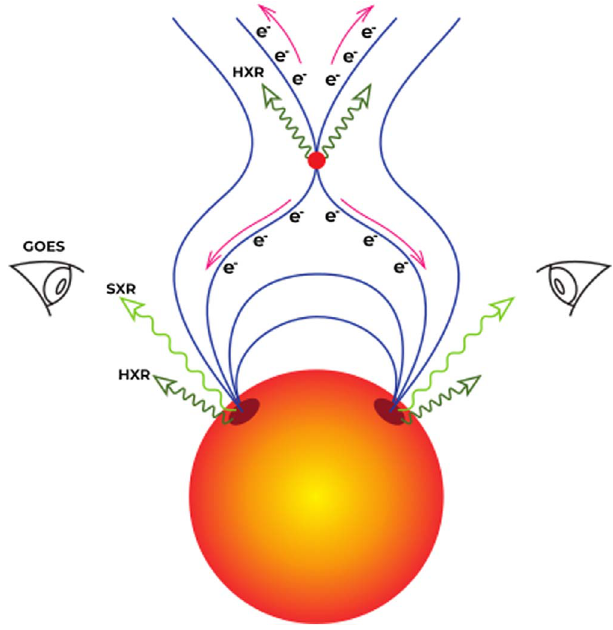
Fig. 1. Illustration of the Neupert effect showing the causal relationship between SXR and HXR emission. Electrons are accelerated near the reconnection region (red dot) whereafter they propagate back to the Sun as well as radially outward. The footpoints and the reconnection region become sources of SXR and